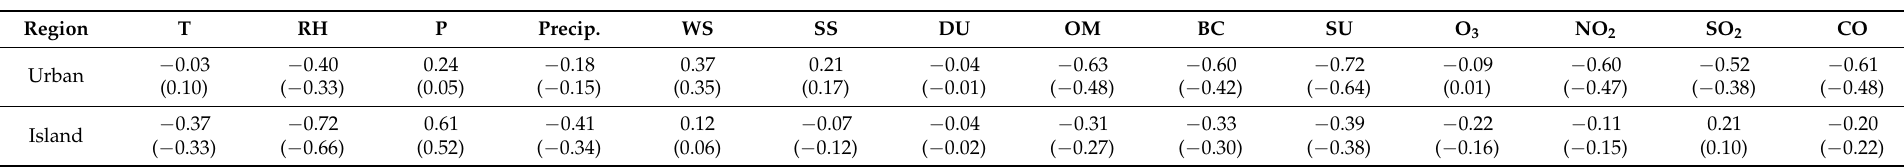
Table 3. Comparison of VIS ASOS , VIS LDAPS , and VIS RF in urban and island regions (show bias, RMSE, and R) and mean data for meteorological variables. Parentheses values in precipitation are the number of precipitation days. SS DU OM BC SU O 3 NO 2 SO 2 CO T P RH VIS ASOS WS Precip. Bias RMSE Region Model R ( ◦ C) (hPa) (%) (km) (m/s) (mm) (km) (km) LDAPS 1.01 Urban − 0.26 2.10 0.85 LDAPS 4.23 5.45 0.40 Island 0.89